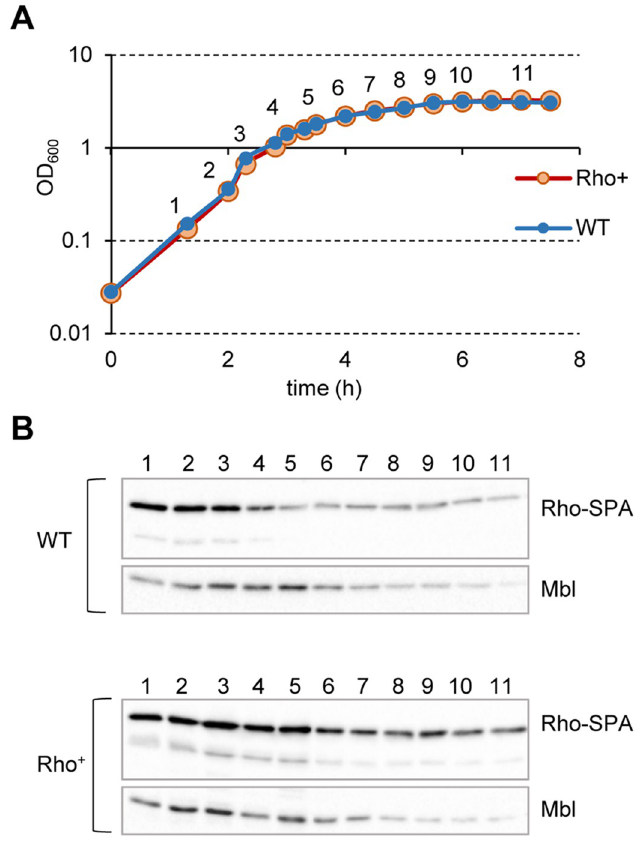
Fig 1. Heterogenic expression of the transcription termination factor Rho. B . subtilis cells expressing SPA-tagged Rho protein from natural (WT) and P veg (Rho + ) promoters were grown in LB medium ( A ) and analyzed for Rho protein content at the indicated time points by immunoblotting with ANTI-FLAG M2 monoclonal antibodies (Rho- SPA; B ). Equal amounts of total protein extracts were loaded onto the gel according to Bradford assay; samples’ equilibrium between the strains at each time-point and the quality of transfer were controlled by visualization of Mbl protein using specific anti-Mbl antibodies (Mbl; B ). Note that the Mbl levels decrease in stationary phase.